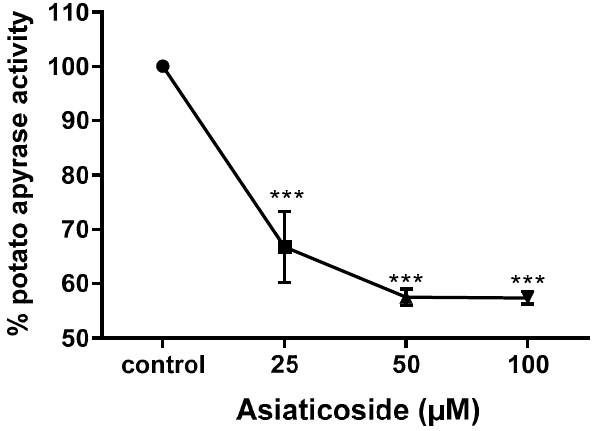
Figure 4. Effects of asiaticoside on the ATPase activity of potato apyrase. Asiaticoside was assessed based on the activity observed for the control, which represents 100% of the ATPase activity. For each drug concentration, a DMSO control was performed. Basal activity in the absence of asiaticoside or DMSO was 22.053 µ mol Pi · mg − 1 · min − 1 . Each analysis represents an experiment done in triplicate. *** p < 0.001 compared with control group using the Dunnett’s multiple-comparison